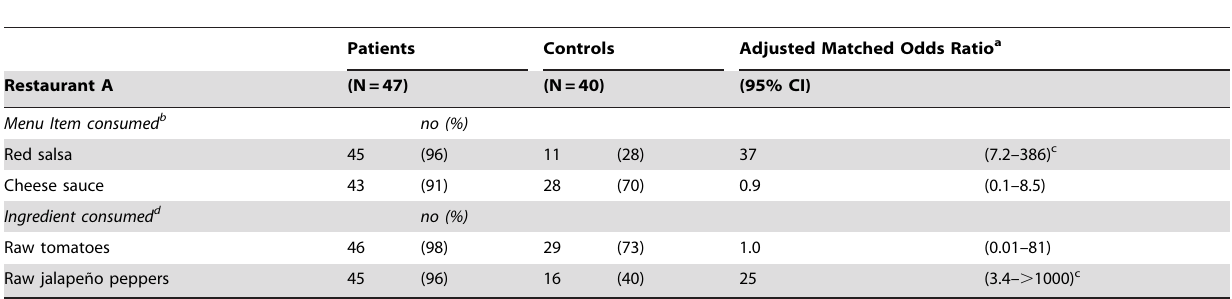
Table 2. Multivariate assessment of associations of menu items and ingredients with illness among Restaurant A